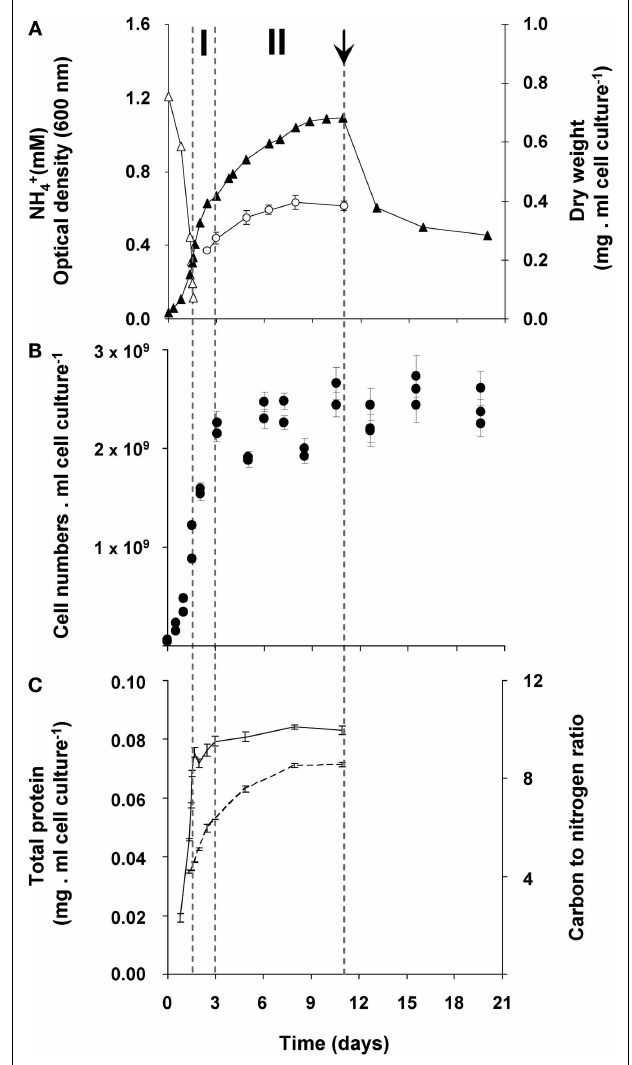
FIGURE 1 | Growth response of “ Ca. M. fumariolicum” SolV upon ammonium depletion. (A) Growth was monitored by measuring increase in optical density (closed triangles) and dry weight (open circles). Error bars represent SEM ( n = 4). Concentration of ammonium is represented by open triangles. After 1.5days of exponential growth ( µ max = 0.07h − 1 ) ammonium was depleted and two phases were observed, indicated by dashed lines and the symbols I and II. At day 11 (arrow), cell cultures were diluted into ammonium containing medium, but without methane added.To compare with the original optical density and cell numbers, values were multiplied by the dilution factor. (B) Cell numbers per ml cell culture of “ Ca. M. fumariolicum” SolV (solid circles). Error bars represent SEM ( n = 30). (C) Total protein (solid line), determined in the crude extracts prepared from harvested cells and carbon to nitrogen ratio of the harvested cells (dashed line). Error bars represent SEM ( n =